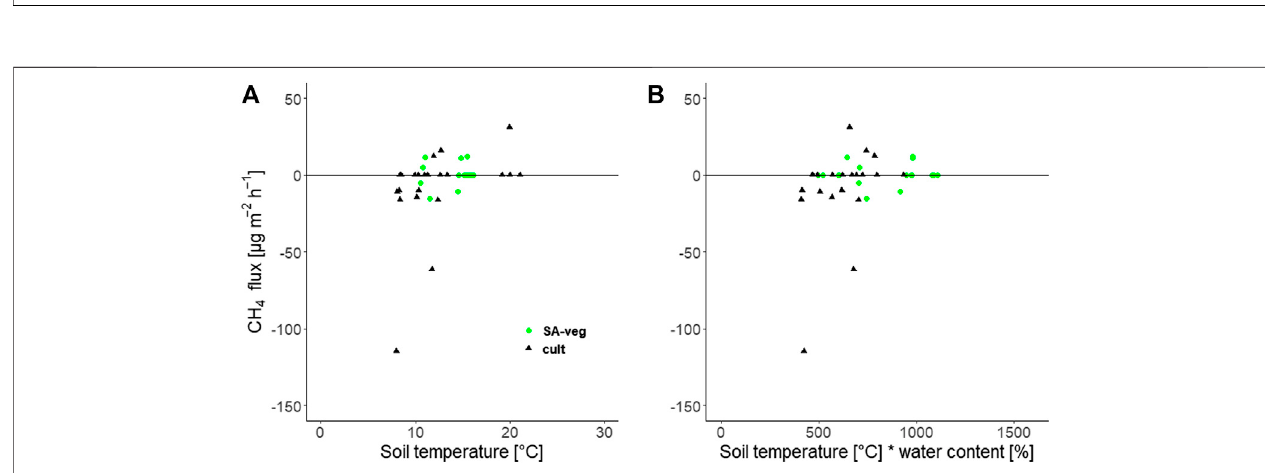
FIGURE3| Nitrousoxide(N 2 O) fl ux[µgm − 2 h − 1 ]asafunctionof (A) soiltemperatureat5cmdepthand (B) theinteractionbetweensoiltemperatureandvolumetric water content, at the set-aside site (SA-veg ( ○ )) and the cultivated site (cult, ▲ ). No signi fi cant relationship was found.